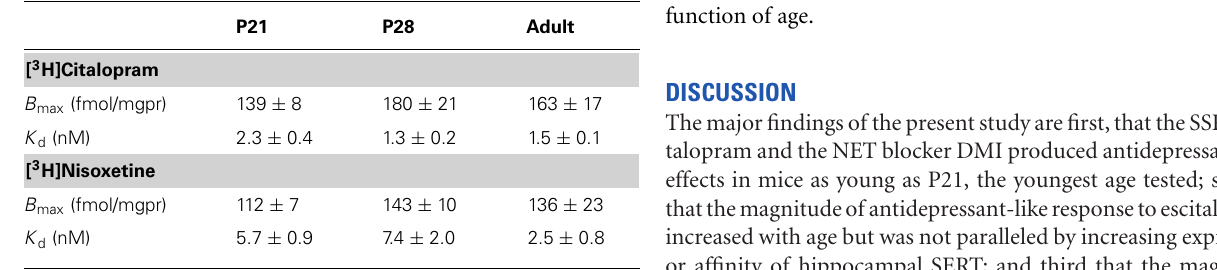
Table 1 | Summary of B max and K d values for [ 3 H]citalopram binding to SERT and [ 3 H]nisoxetine binding to NET in male P21, P28, and adult mice.